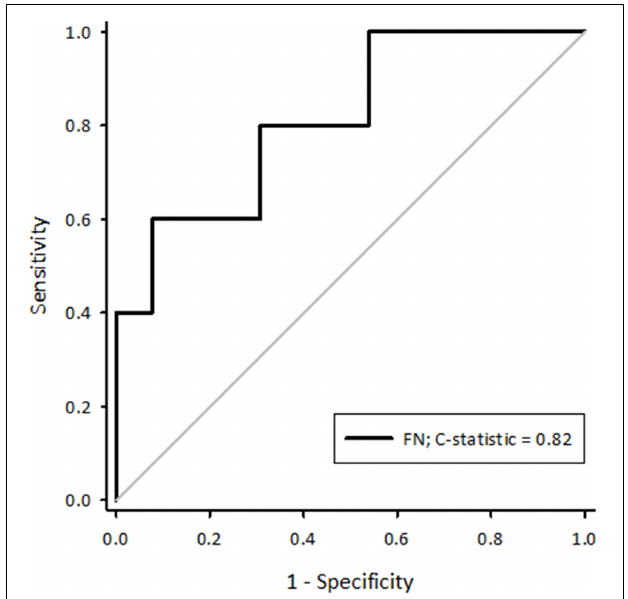
FIGURE 1 | A receiver-operator characteristic curve generated for fibrillation number calculated using a paced cycle length of 273 ms. The C-statistic